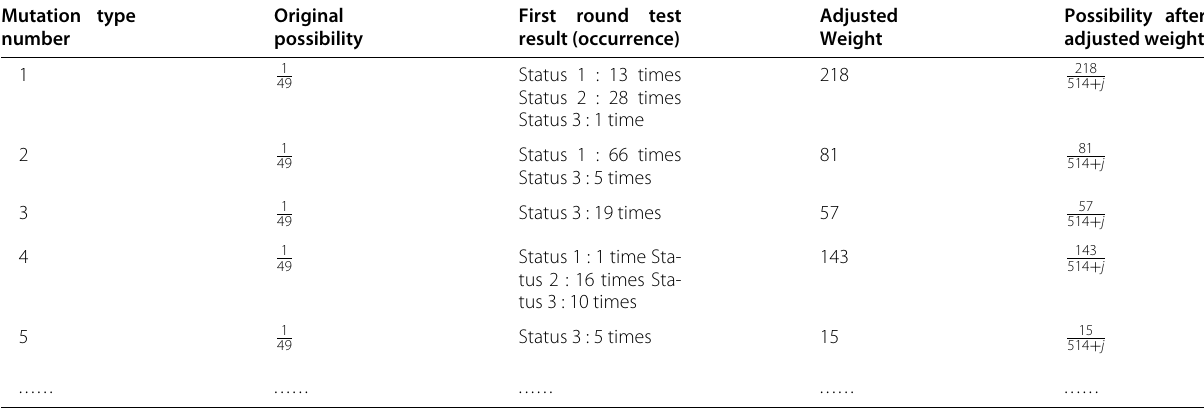
Table 2 The probability of occurrence of five mutation types in the first round and the second round depending on the status of the feedback from the DUT Mutation type